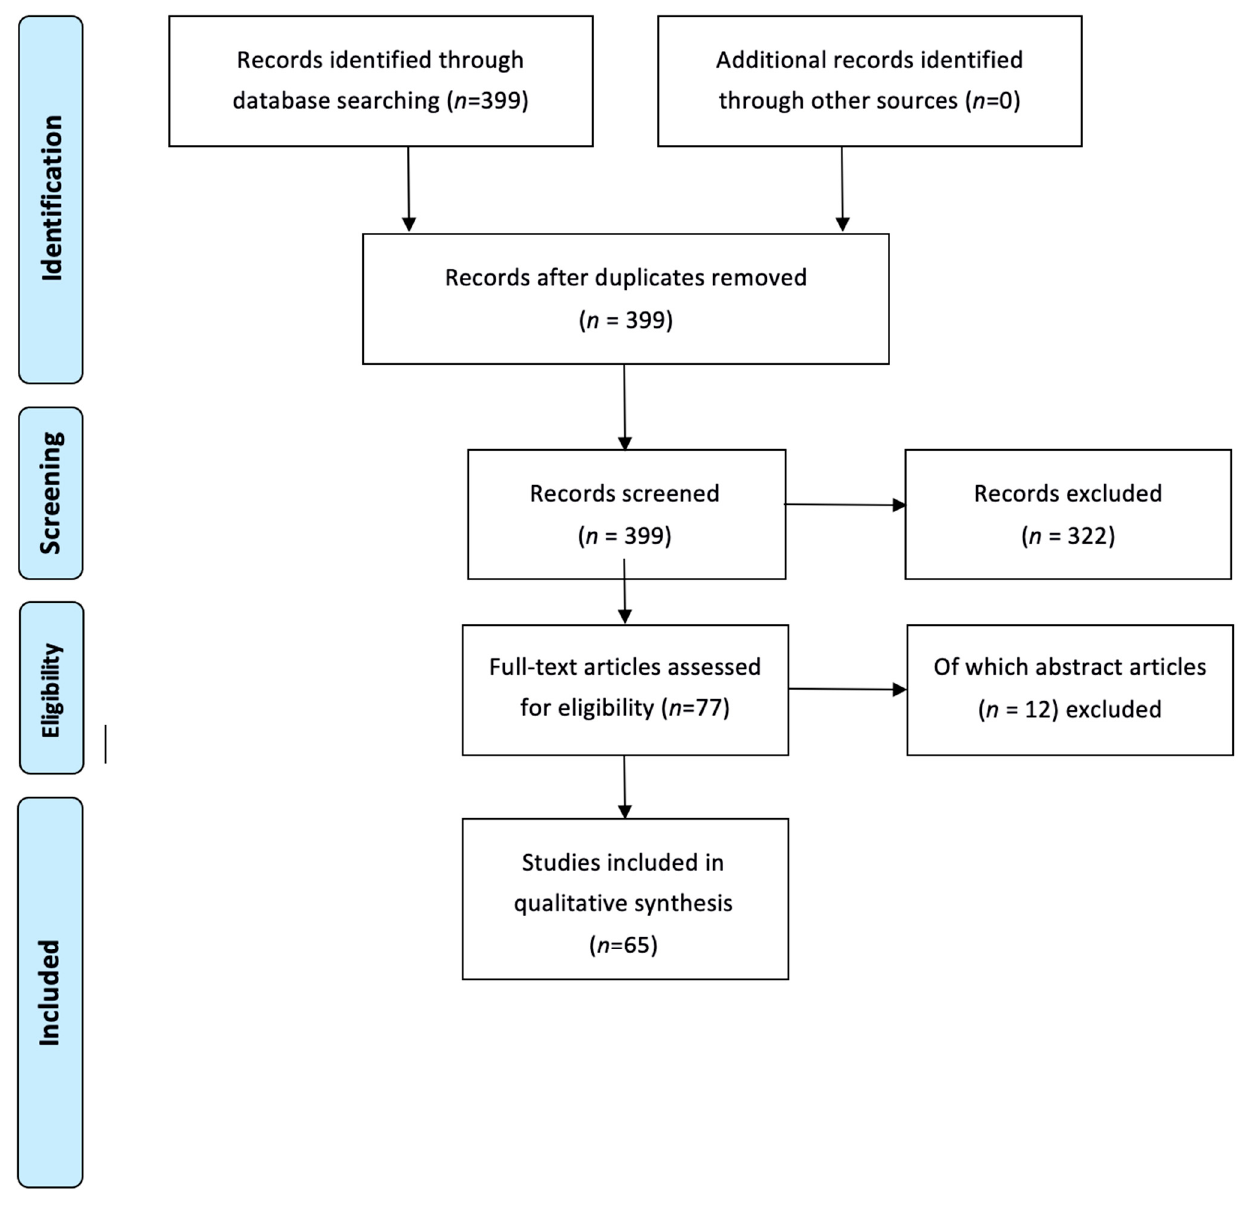
Figure 2. Flowchart. Table 2. Number of studies according to their marker type and Table 2. Number of studies according to their marker type and results.